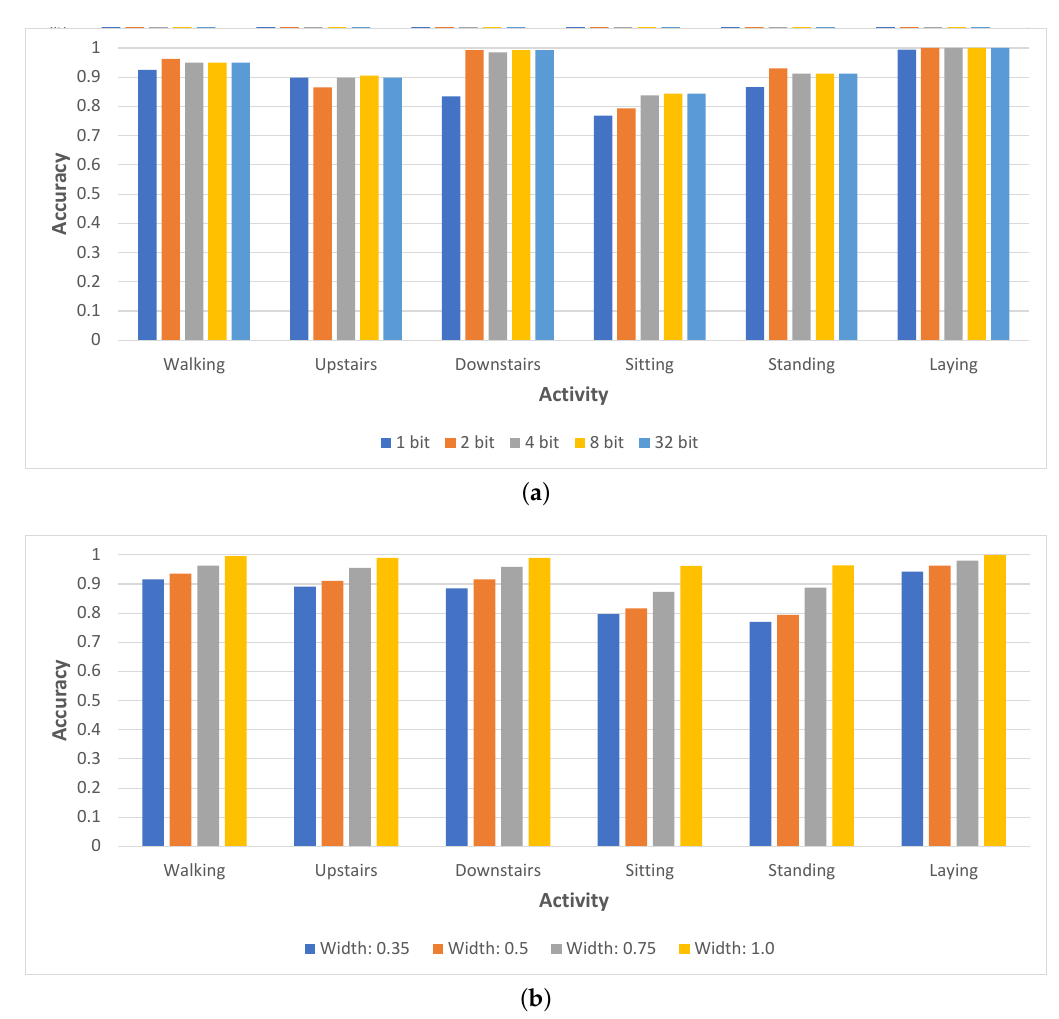
Figure 4. Per-activity accuracy of both networks for various compression levels. ( a ) Any-Precision deep neural networks. ( b ) Slimmable Neural